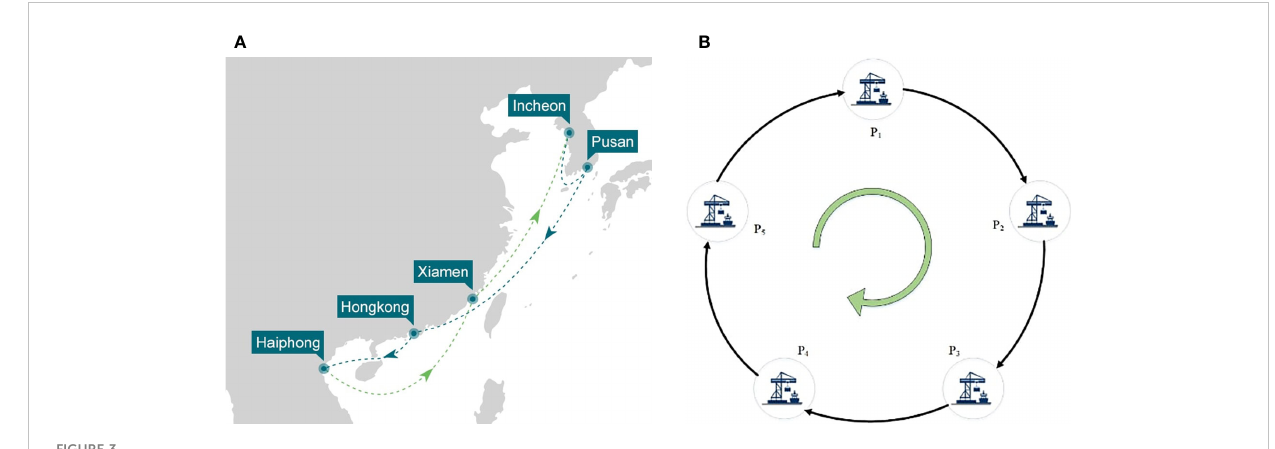
FIGURE 3 (A) real shipping route; (B) concept of circle voyage.